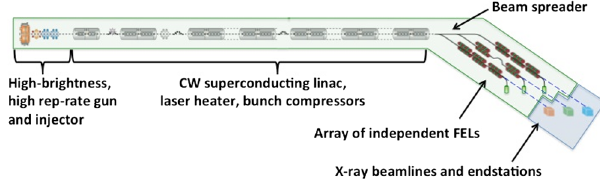
FIG. 1. Amplitude of the Fourier coefficient difference from the FFT of an analytical Gaussian function and a sampled Gaussian function with 10 k, 100 k, 1 M, and 10 M macroparticles.